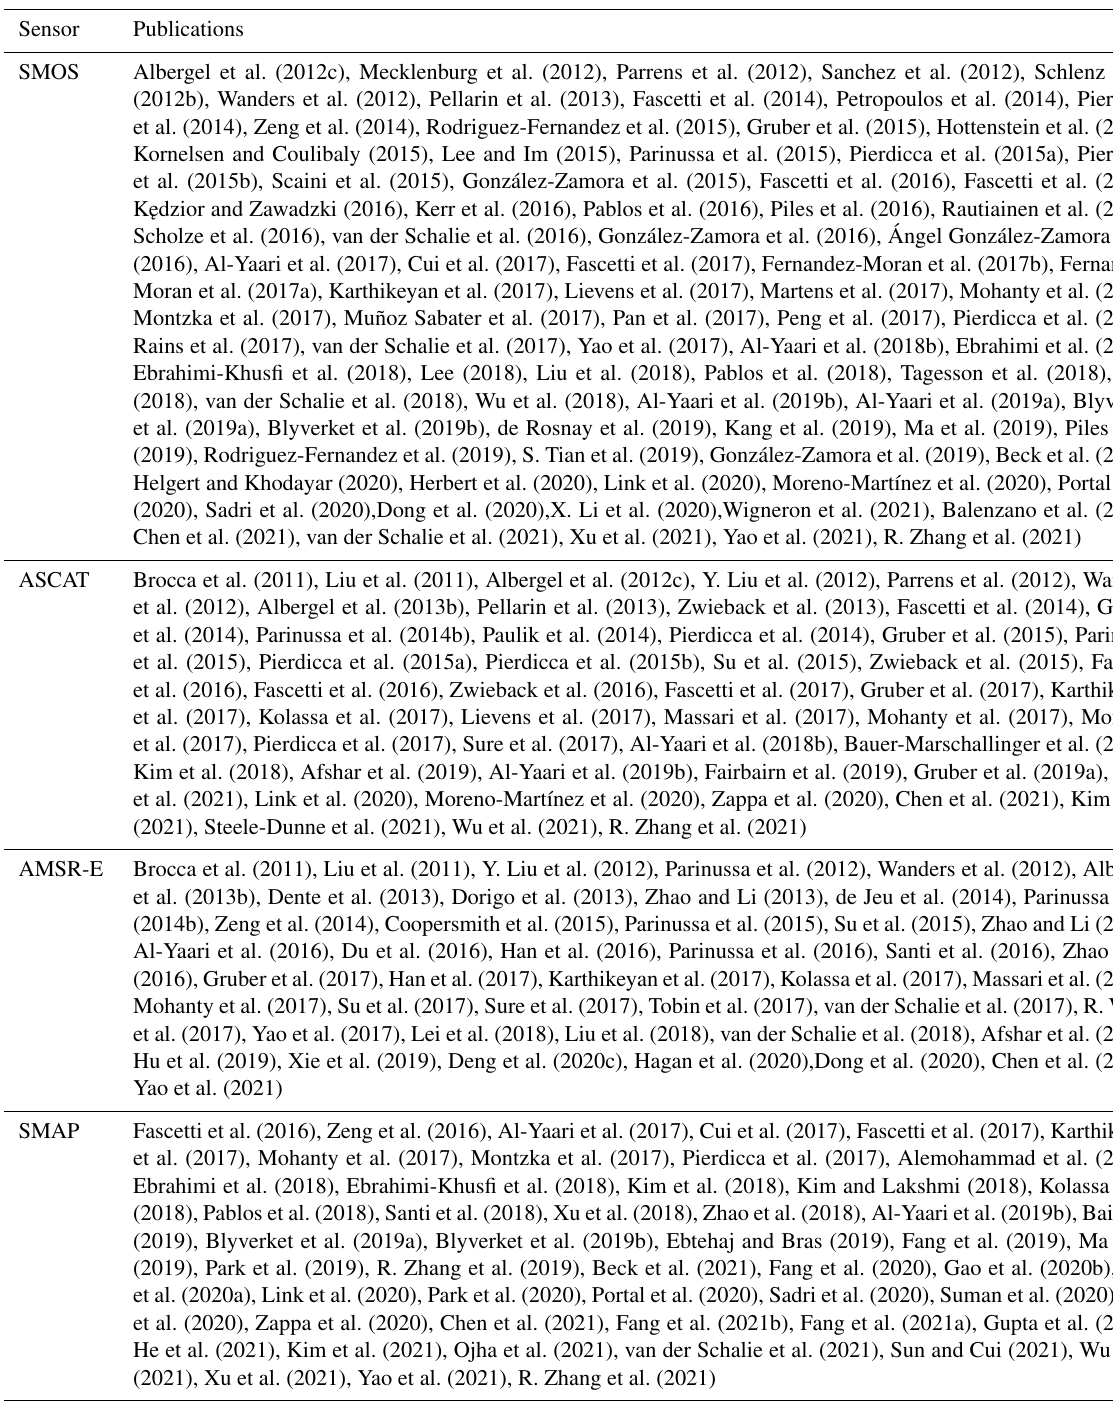
Table E1. Overview of scientific studies using ISMN data for satellite product evaluation and